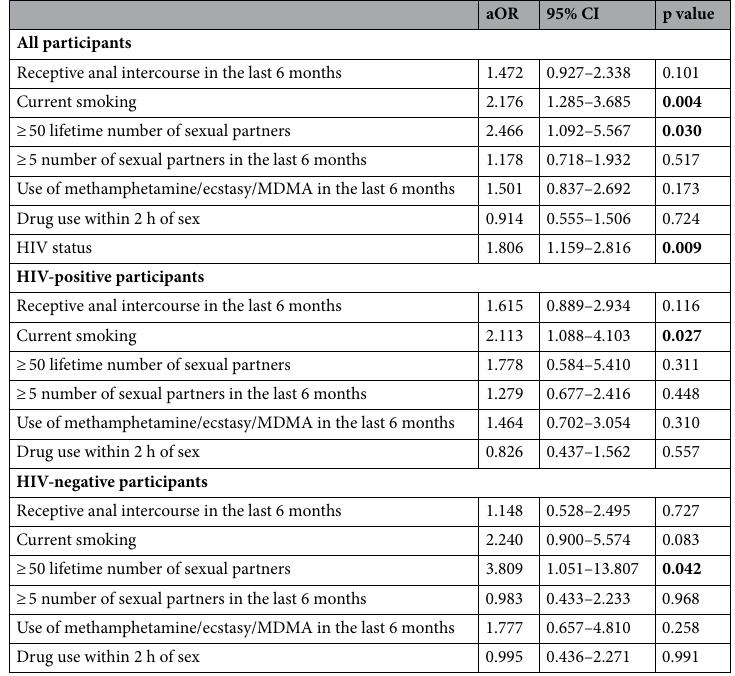
Table 2. Multivariable analysis of risk factors for anal HR-HPV infection. aOR adjusted odds ratio, CI confidence interval, Hosmer–Lemeshow goodness-of-fit statistics, p = 0.777. P value of < 0.05 was determined as statistically significant (bolded).